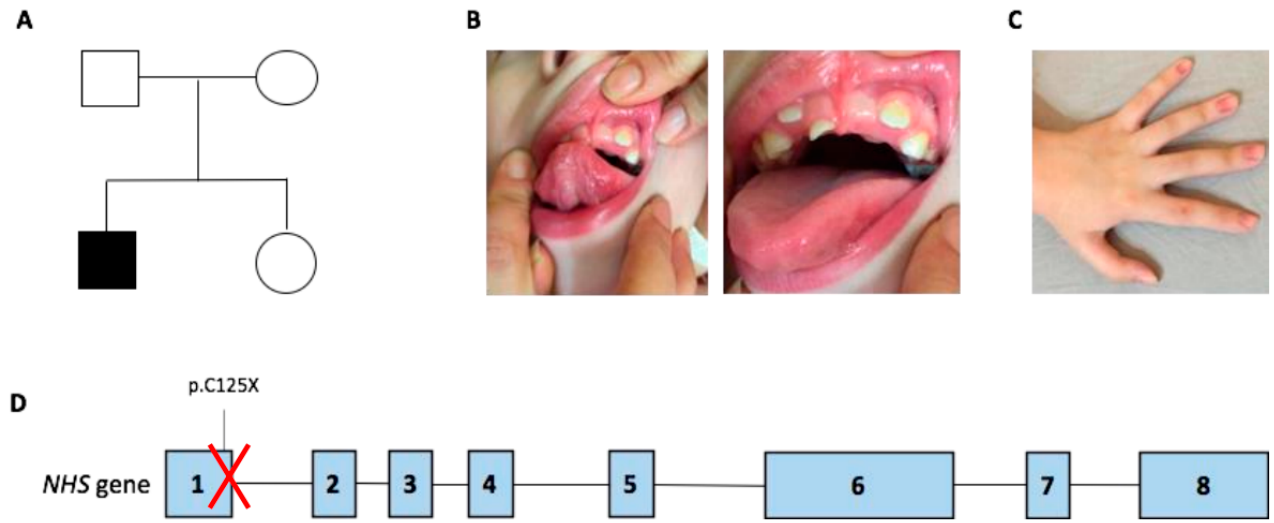
Figure 1. ( A ) Pedigree of the family. ( B ) Dental anomalies of the patient, including notching of incisors and supernumerary teeth (right and left panel). ( C ) Note the mild dyschromia of sub-ungual space. ( D ) Schematic representation of the NHS gene with the p.C125X hemizygous variant identified in the exon 1 of the